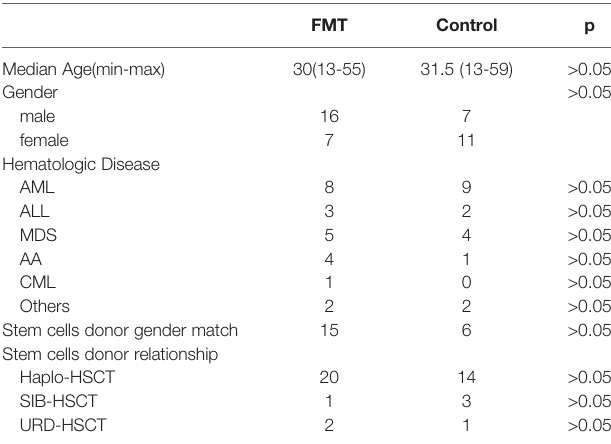
TABLE 1 | Baseline characteristics of patients.